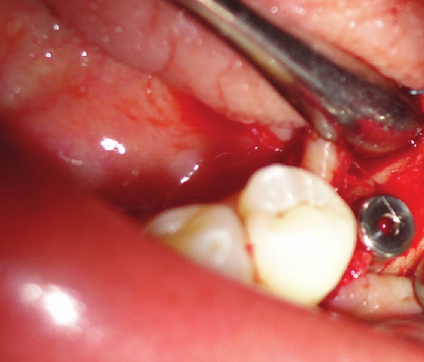
Figure 1: Preoperative Dentascan.